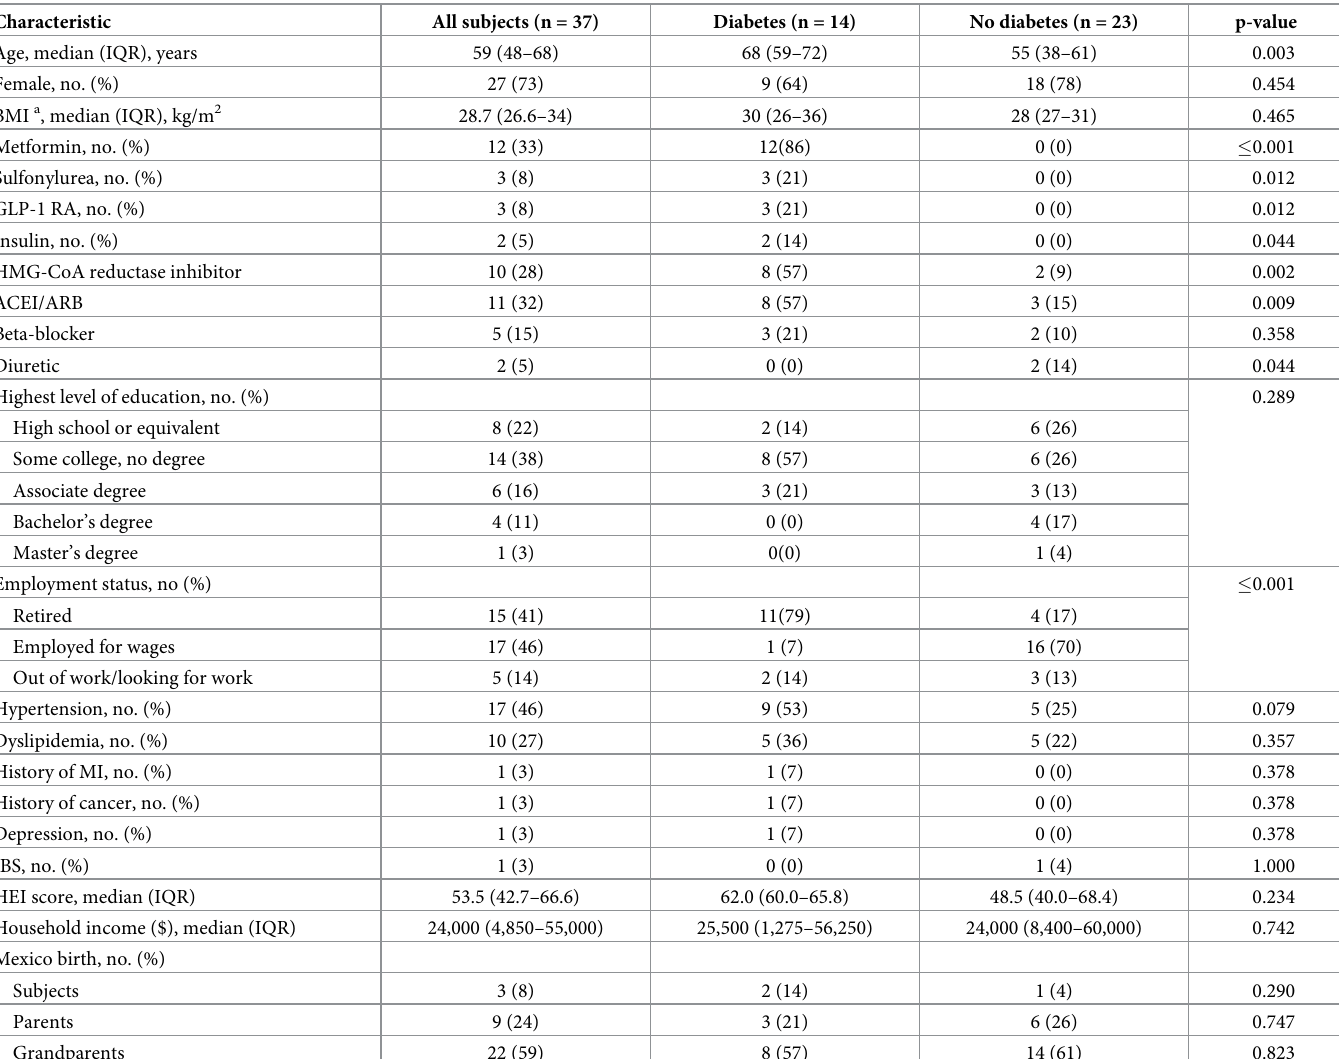
Table 1. Baseline